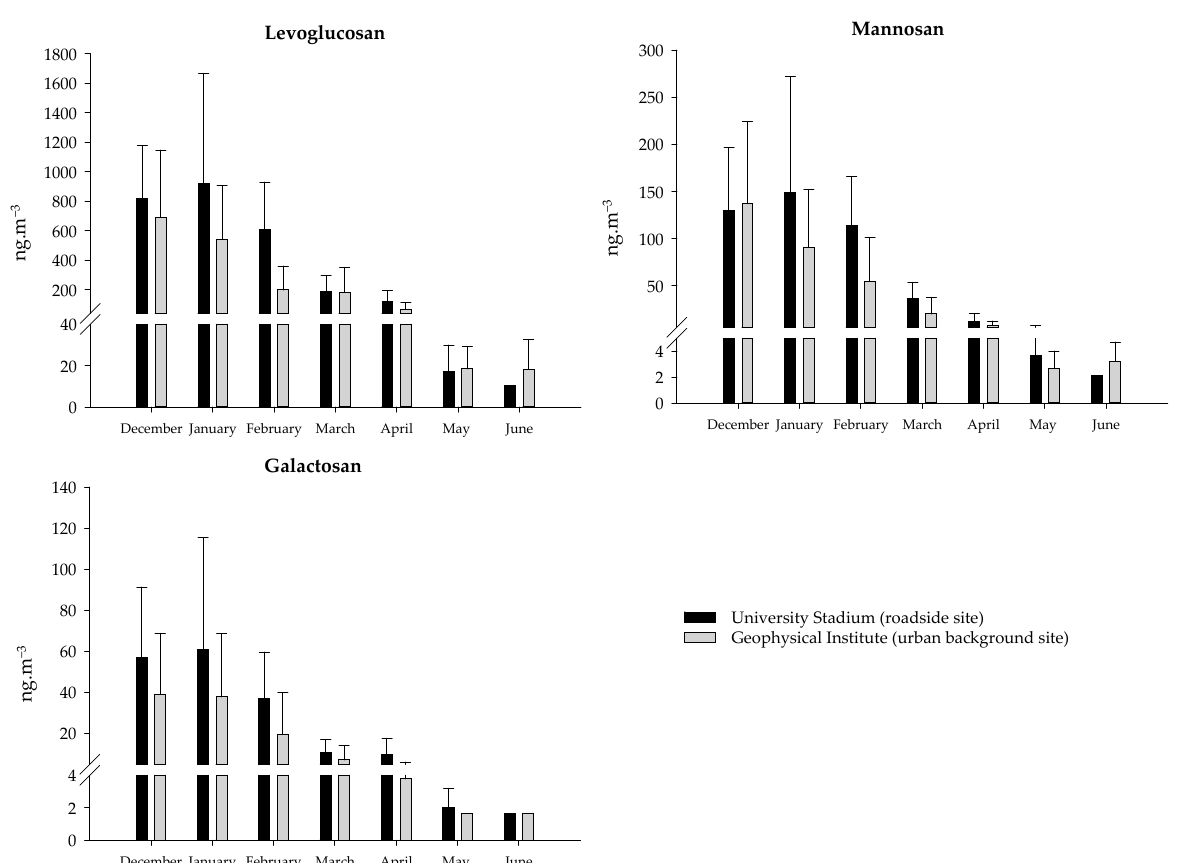
Figure 2. Monthly variation of concentrations of anhydrosugars during the sampling campaign in Coimbra. Furthermore, strong and positive correlations were observed between concentrations Table 6. Spearman correlations between sugar compounds, organic carbon and meteorological of the two sampling sites, suggesting that biomass combustion affects air quality not only locally but in a larger area. This marked seasonal pattern is most likely associated with the use of biomass-fueled heating appliances due to low-temperature values in the colder